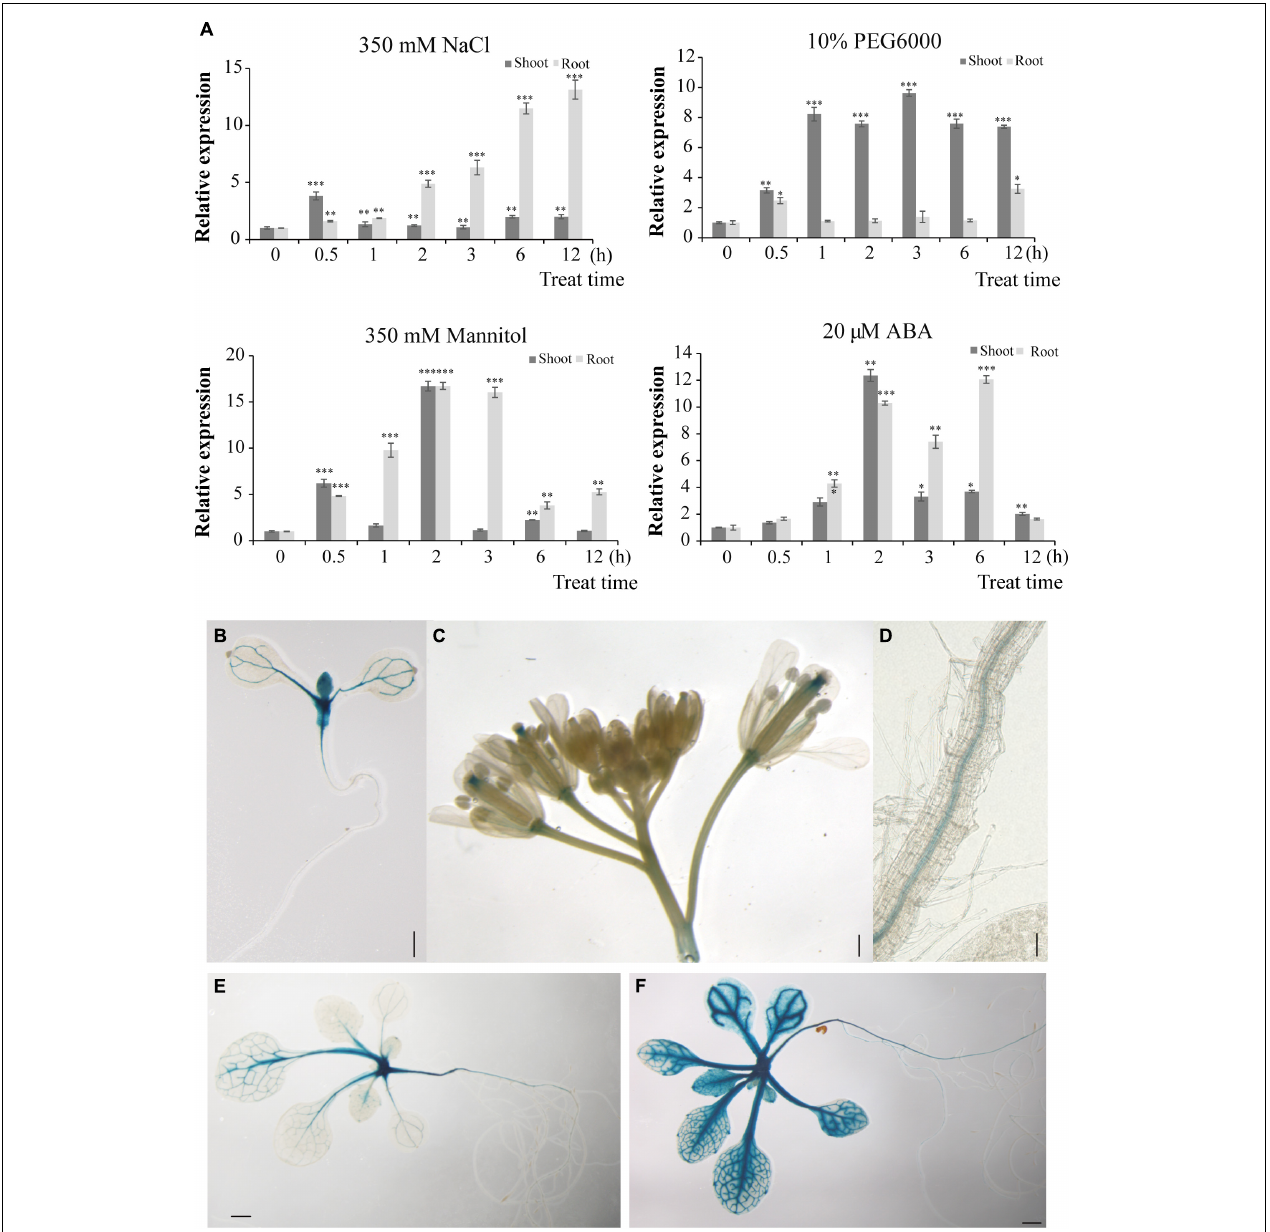
FIGURE 4 | HbERF6 is inducible under different stress conditions and GUS activity is mediated by the HbERF6 promoter in transgenic Arabidopsis plants. (A) Transcript levels of HbERF6 in roots and shoots of wild barley at two-leaf and one-heart stage suffering from salt (350 mM NaCl), water deficiency (10% PEG6000 and 350 mM mannitol), and ABA (20 µ M) using qRT-PCR. 18SrDNA was used as an internal reference gene. Each value is the average of three biological replicates and error bars mean ± SD. Asterisks indicate significant variation ( ∗ P < 0.05, ∗ P < 0.01 and ∗∗∗ P < 0.001). (B) The 8-day-old pHbERF6:GUS seedlings after imbibition of seeds, (C) inflorescence, and (D) primary roots, the 15-day-old seedlings after imbibition of seeds in MS medium (E) and after 100 mM NaCl treatment for 16 h (F) . Scale bars = 2 mm in (B) , 1 mm in (C–E) , and 400 µ m in (F)